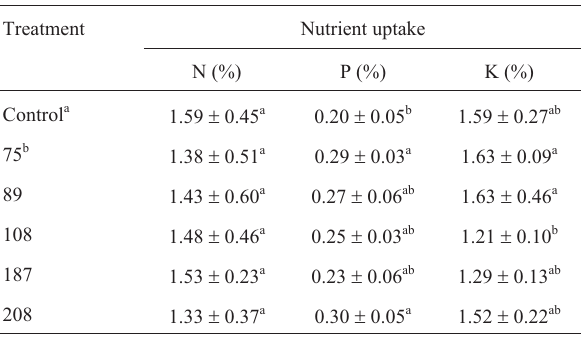
a Plants without bacterium inoculation. b Plants with bacterium inoculation. The data represent the means of seven plots per treatment in the green- house assay followed by the standard deviation. Values in the same col- umn followed by the same letter did not differ significantly at p > 0.05 (Tukey’s